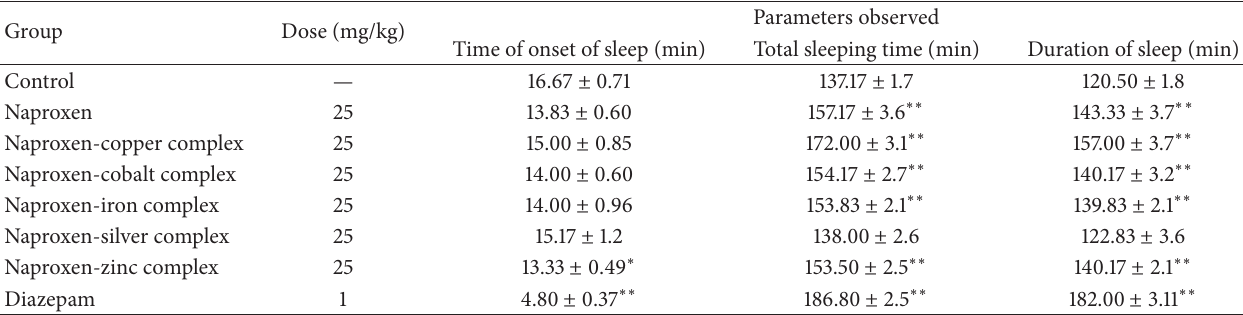
Table 4: Effect of naproxen metal complexes on phenobarbitone sodium-induced sleep.